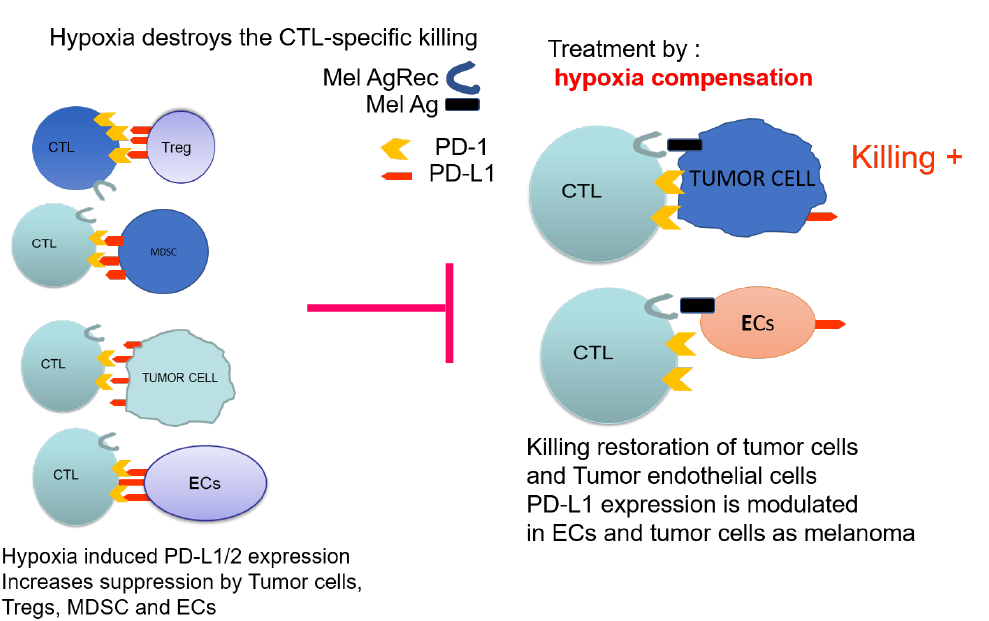
Figure 2. PD-1/PD-L1 pathway as hypoxia dependent: Effect on immunosuppression . indicates the blocking effect of hypoxia-induced PD-L1 towards normal killing.